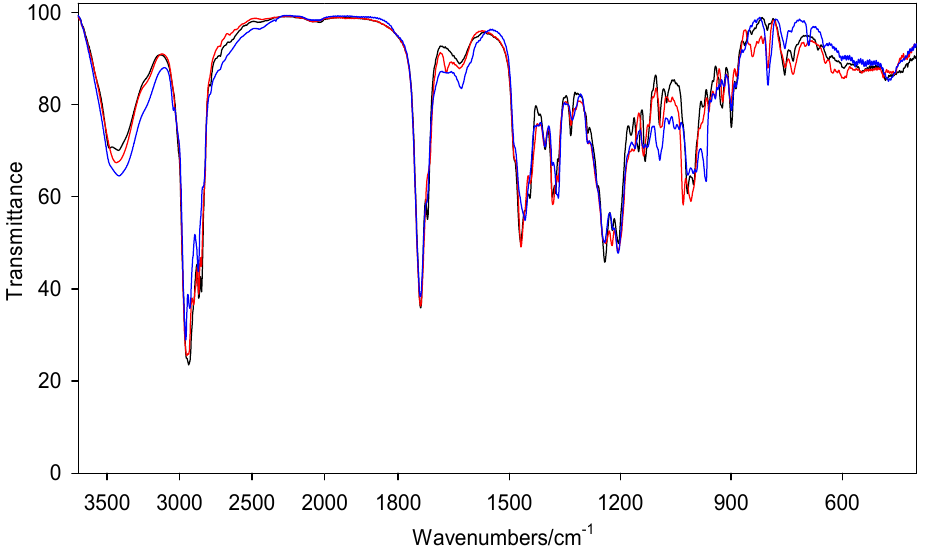
Figure 2. FT-IR spectra of conjugates 6 (blue), 9 (red), 12 (black) in the 3,500–600 cm − 1 region.